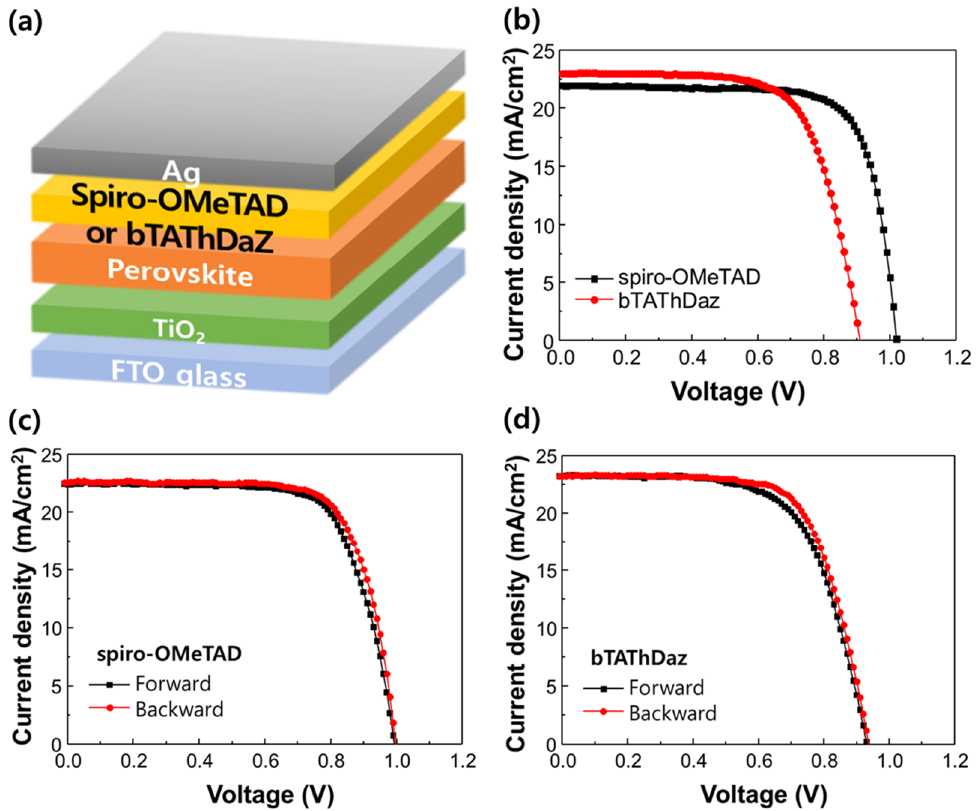
Figure 9. ( a ) Device architecture of perovskite solar cell used for this study. ( b ) Average current density-voltage curves of perovskite solar cells used spiro -OMeTAD and bTAThDaz as hole transport layer (12 samples). Current-voltage hysteresis curves of perovskite solar cells used ( c ) spiro -OMeTAD and ( d ) bTAThDaz measured starting with backward scan and continuing with forward